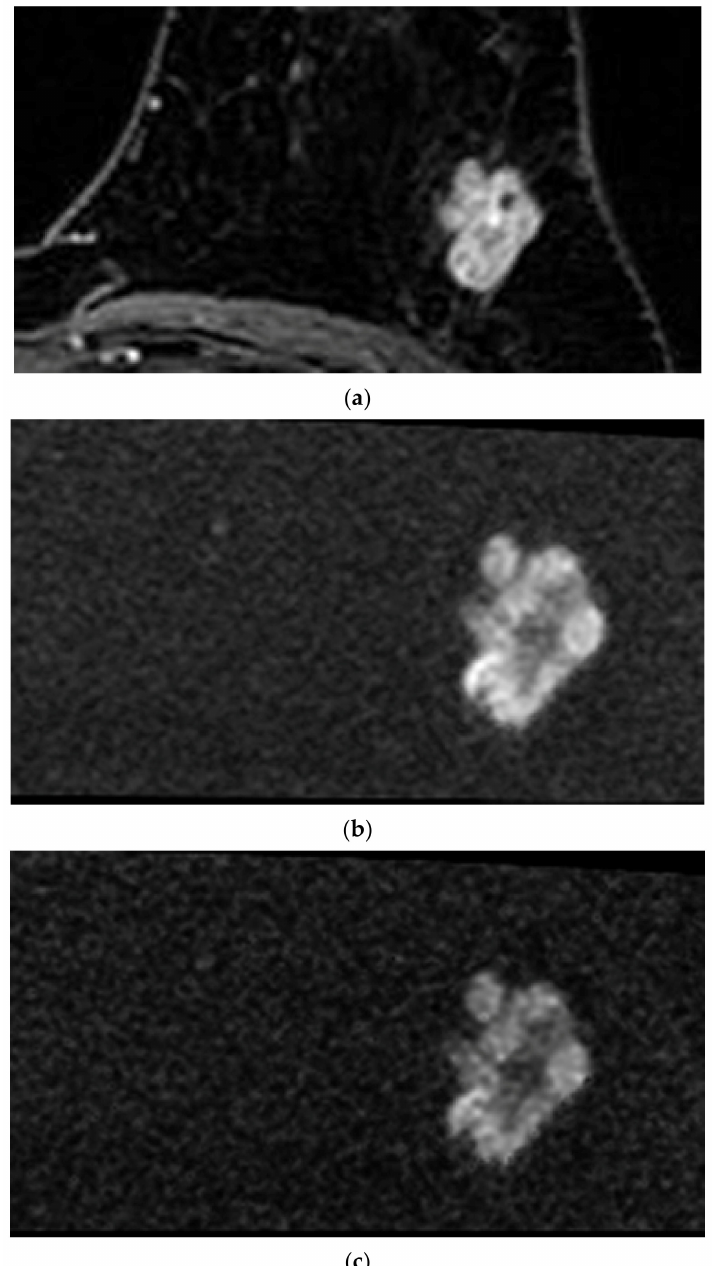
Figure 2. A 63-year old woman who had medullary carcinoma in her right breast. Axial contrast-enhanced T1-weighted fat-suppressed MRI ( a ) shows a 19 × 25 mm-sized enhancing mass with irregular shape, irregular margin, and heterogeneous and marked enhancement in the left 2 o’clock direction. rFOVA-1000 a ( b ) and rFOVS-1500 b ( c ) reveals the well-delineated index tumor, and the irregularity of the shape and the margin of the index tumor is also well depicted. a rFOVA-1000: acquired reduced field-of-view di ff usion-weighted images with b -value 1000 s / mm 2 . b rFOVS-1500: synthetic reduced field-of-view di ff usion-weighted images with b -value 1500 s / mm 2